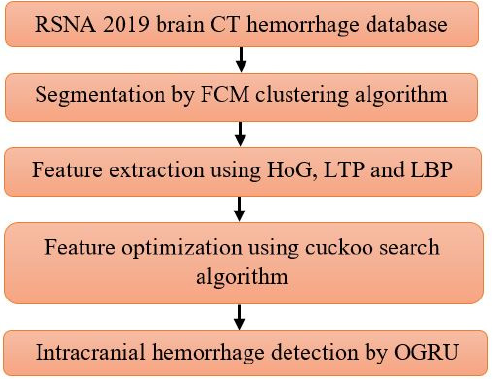
Figure 1. Flowchart of the proposed system.